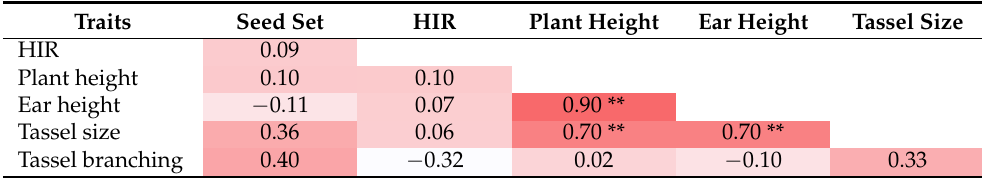
Table 5. Linear correlation among phenotypic traits of 16 haploid inducer genotypes evaluated at the first planting date of 2018.